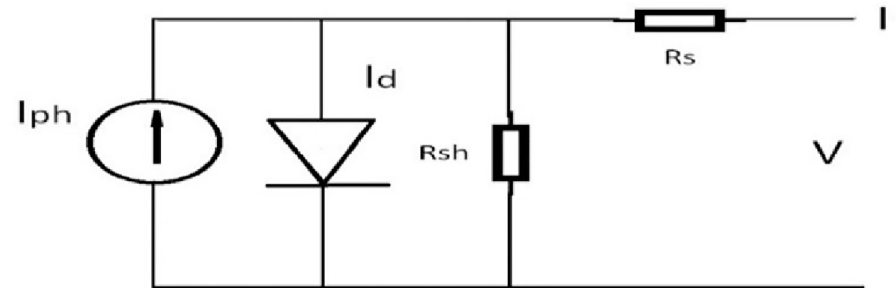
Fig 1. One-diode model of a practical P.V.